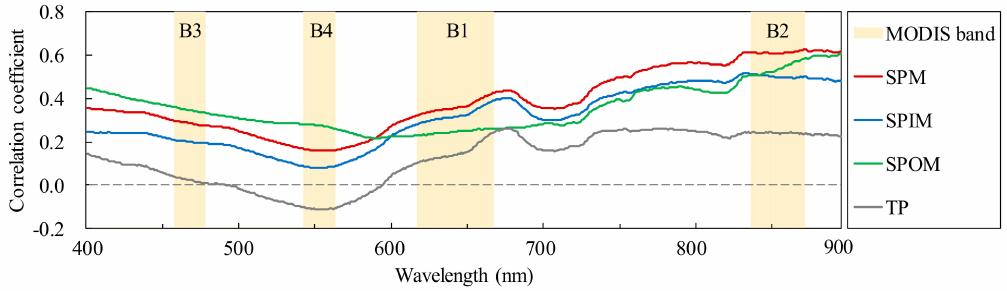
Figure 5. The correlation coe ffi cients between the SPM, SPIM, SPOM, TP, and R rs measured in the